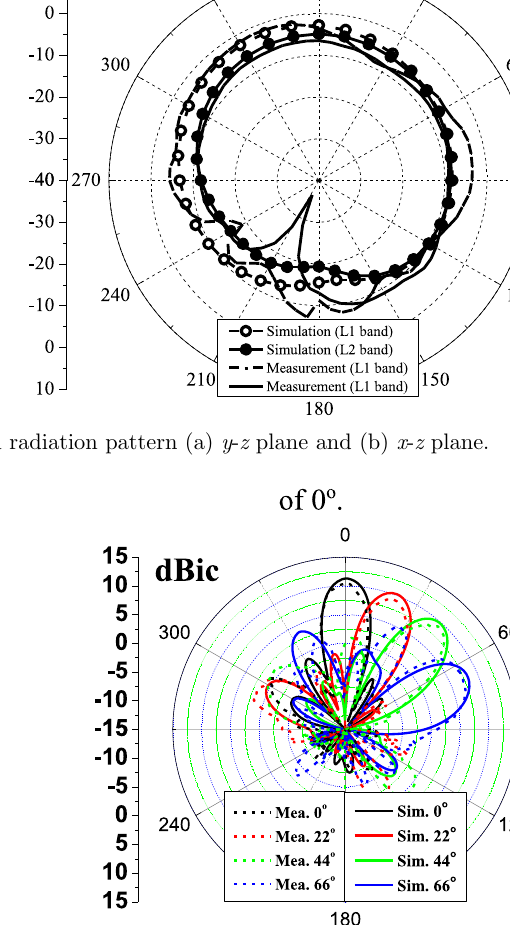
Fig. 19. Simulated and measured radiation patterns of 1 (cid:3) 8 array antenna at various steering